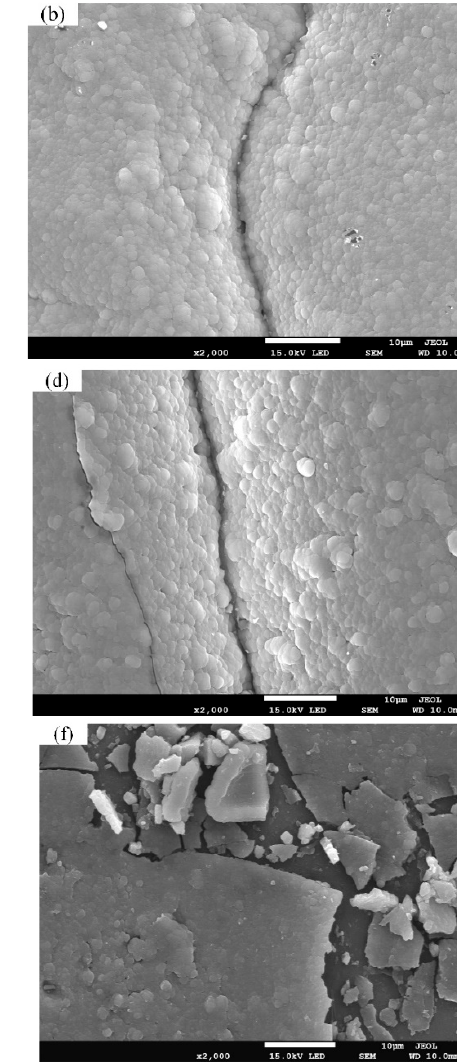
Figure 2. SEM images show the overview of patch-like networks of (Ti:N)-GLC films: ( a ) Ti-C (100); ( b ) TiC-C (100); ( c ) TiN-C (100).